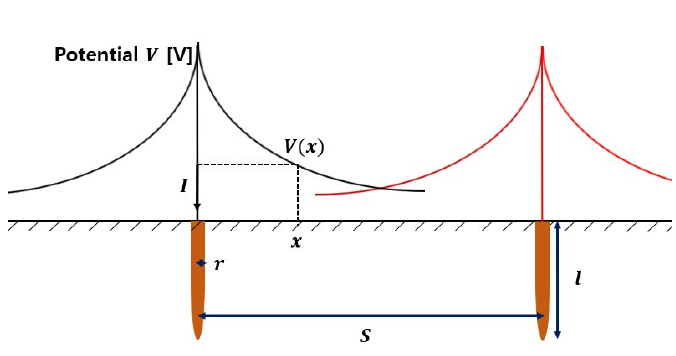
Figure 9. Schematic diagram of the potential distribution of electrodes connected in